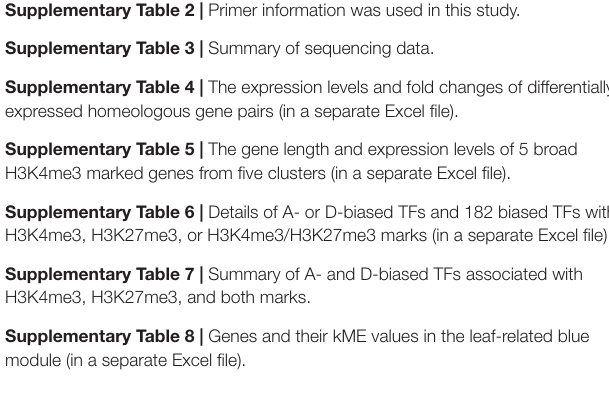
Supplementary Table 3 | Summary of sequencing